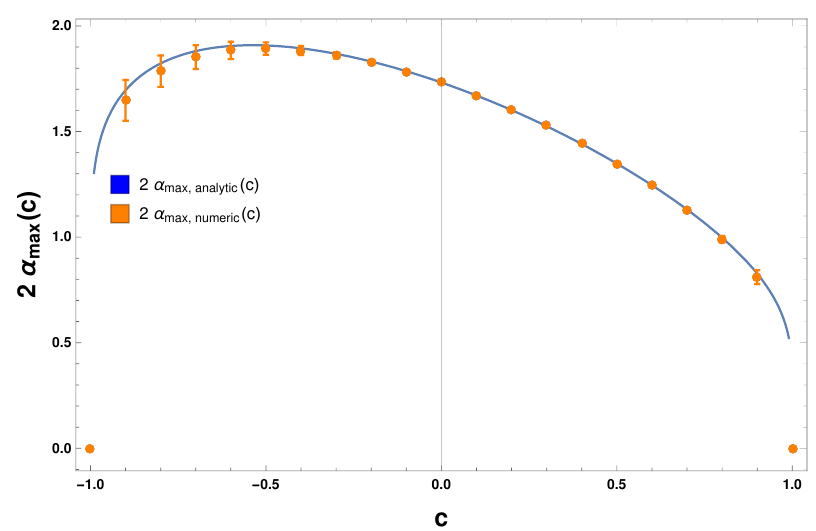
Figure 9. Evaluation on the semi-analytic bound on 2 α . The analytic curve is obtained by maximizing the value of 2 α ( E ) over the allowed energy range and finding the extremum for each value of c . The result closely matches (especially near the maximally chaotic region) with the slope obtained from linear growth of Lanczos coefficients for the FP model in the classical limit (i.e., S → ∞ ). For this purpose, we take the first 50 Lanczos coefficients to determine the slope of the linear